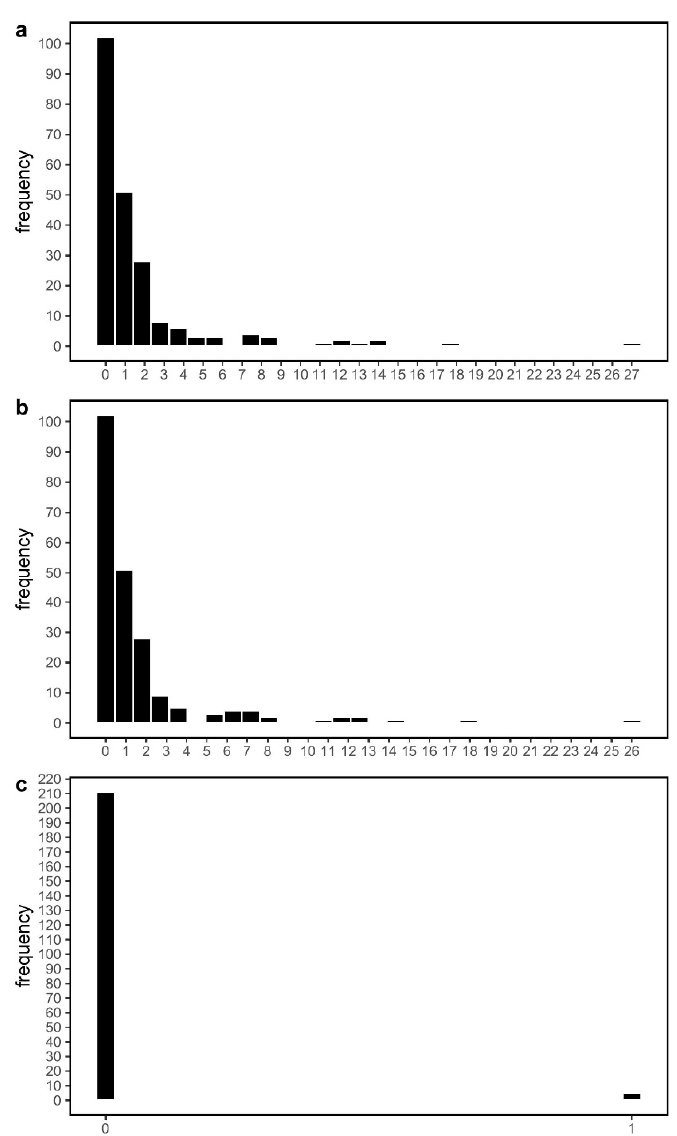
Figure 1. Histograms depicting the frequency of the number of differences between matched SARS- CoV-2 genome sequences. ( a ) total number of differences; ( b ) number of differences where either or both sequences being compared had an IUPAC ambiguity code at a given site; ( c ) number of differences where both sequences being compared had a standard nucleotide base (A, T, G, C) at a given